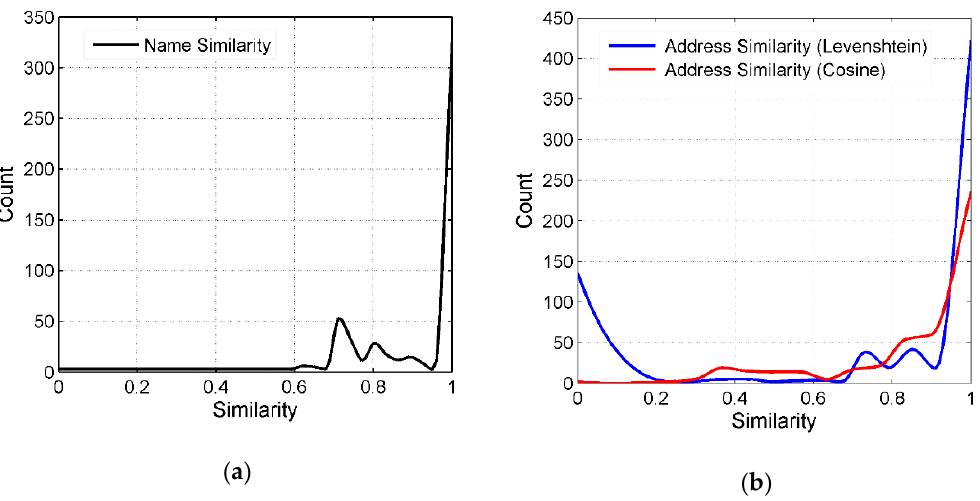
Figure 6. ( a ) The name similarity attribute and ( b ) the address similarity attribute.